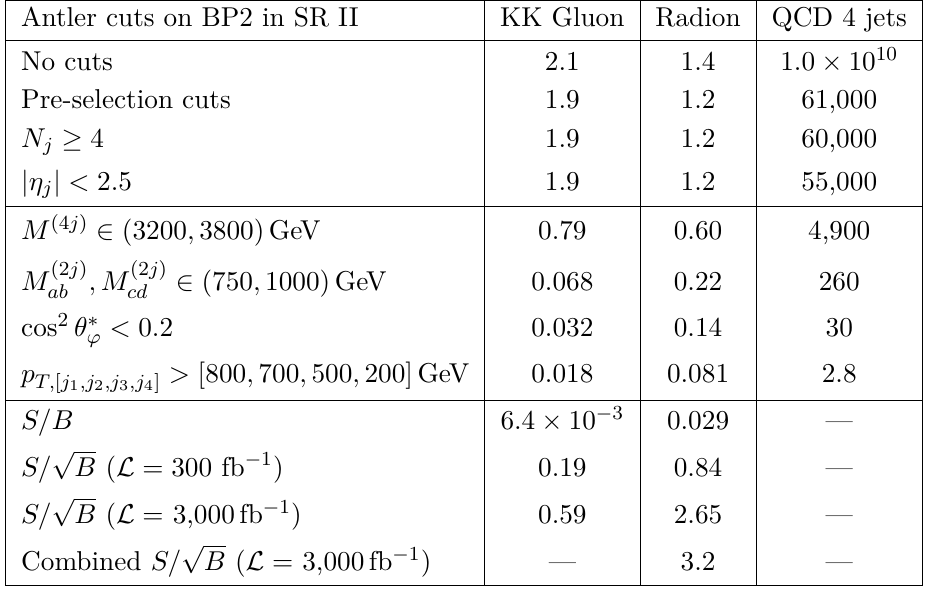
— = 3 . 75 , (cid:15) = 1 , m ( G ) = 3 . 75 TeV , m ( g ) = KK KK KK